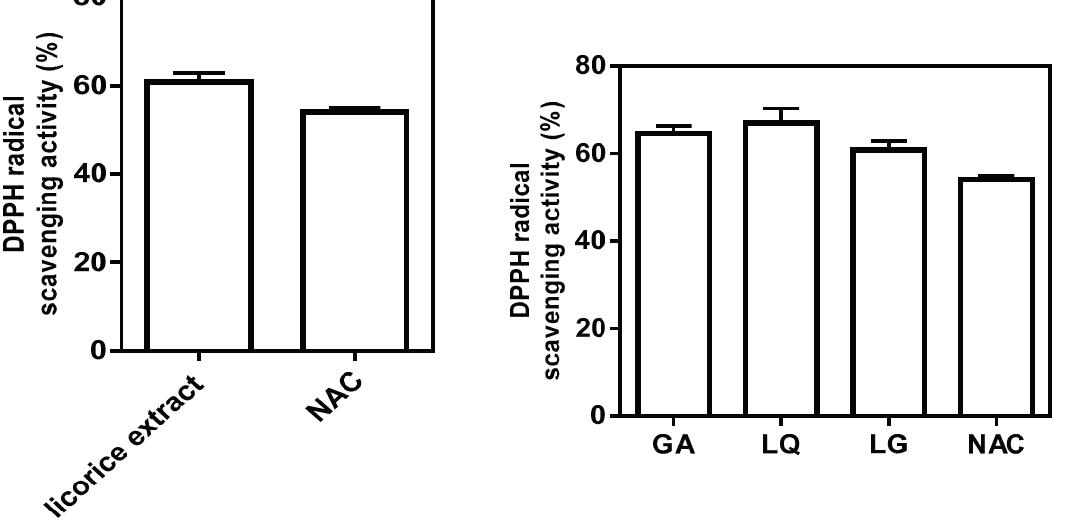
Figure 3. Free-radical scavenging activity of licorice extracts and three ingredients were measured by using the DPPH assay. The direct scavenging activity of licorice extract and its ingredients (GA, LQ and LG) on DPPH radicals was expressed as the % of control at 10 mg/mL of licorice root extract and 100 μ M of GA, LQ and LG. NAC ( N -acetyl cysteine) 10 μ M was used as positive control. The results are the means ± SD of three separate